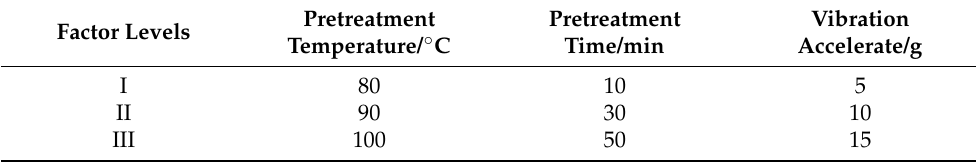
Table 1. Orthogonal experimental design factors and levels L 9 (3 4 ) (1g = 9.8 m/s 2 ).